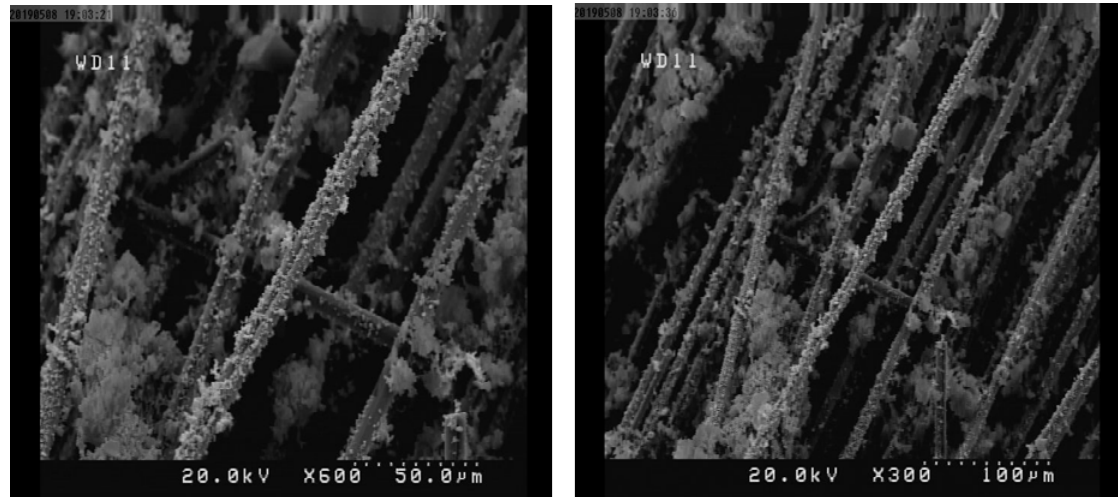
Fig. 7: FE-SEM of coating carbon fibers with